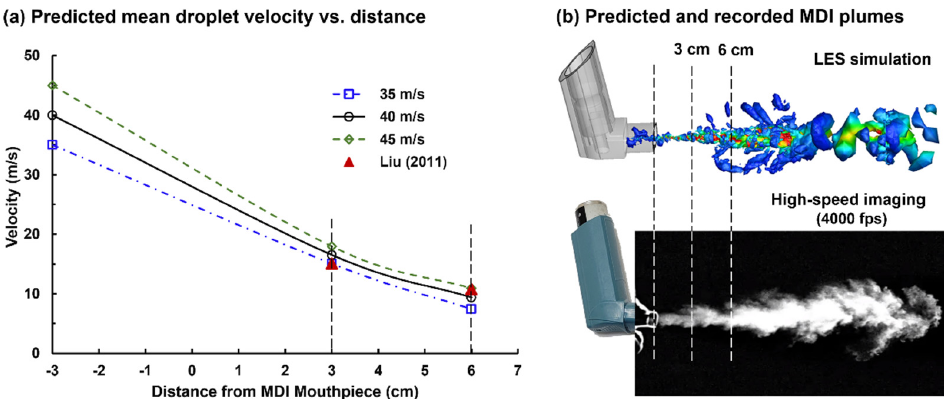
Figure 4. Estimating the droplet exiting velocity at the nozzle based on experimental measurements at downstream locations: ( a ) numerically predicted mean droplet velocities at 3 and 6 cm from the nozzle for three nozzle speeds (35, 40, and 45 m/s) in comparison to the phase Doppler anemometry (PDA) measurements [30]; ( b ) comparison between the numerically predicted and recorded MDI plumes.